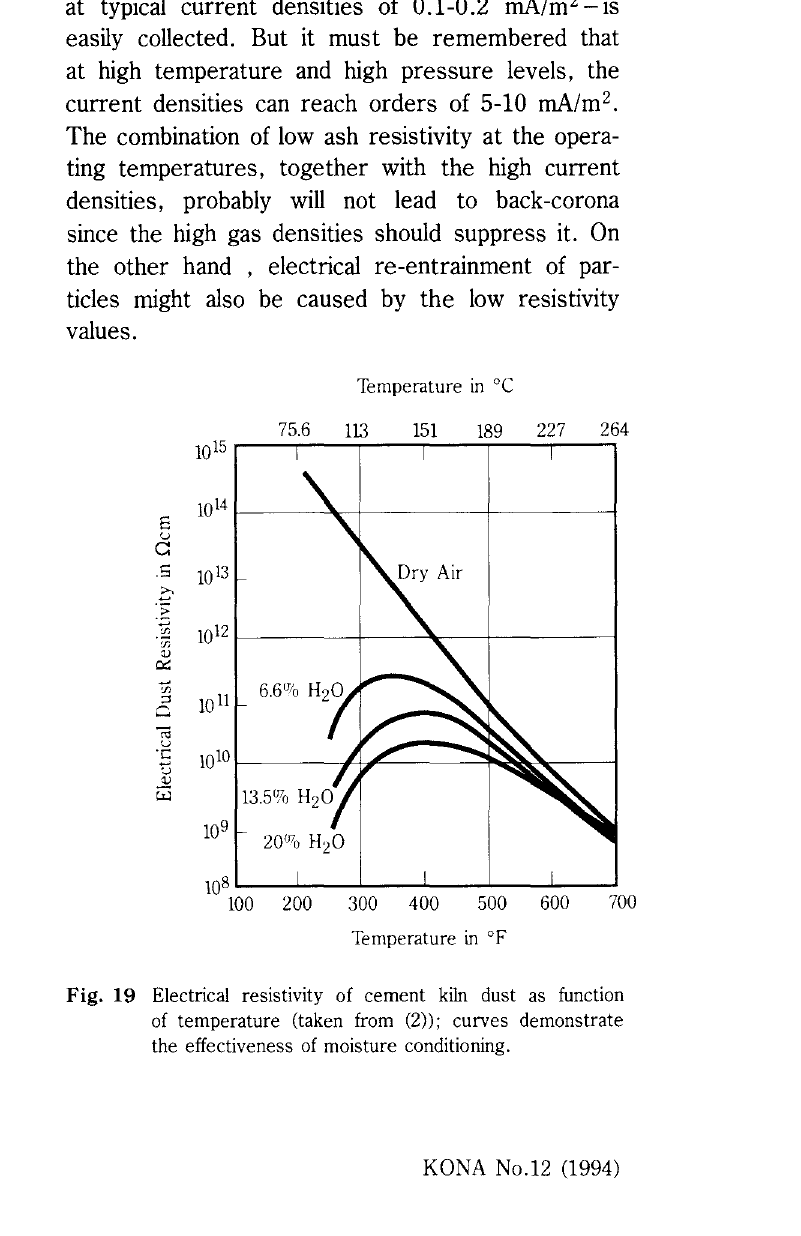
Fig. 18 Efficiency of 1.0 I'm particle (6r ~ 10) for a relative gas density of 4.0, as a function of temperature; different lines correspond to different electrical field strengths. ESP design and operation conditions as before.